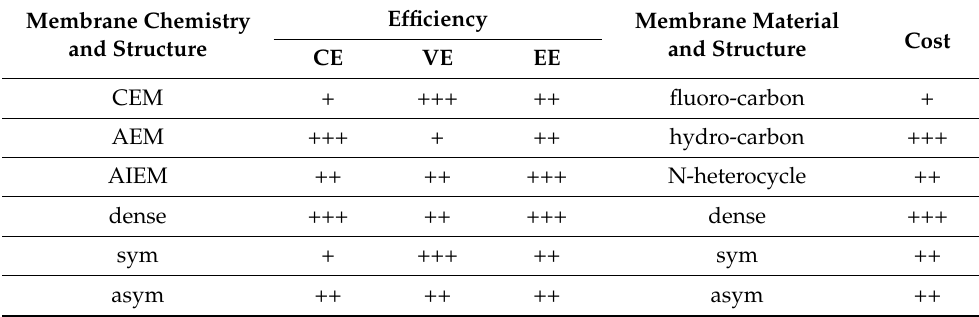
Table 18. Evaluation matrix of polymer membranes (+ less good, ++ good, +++ best). Membrane